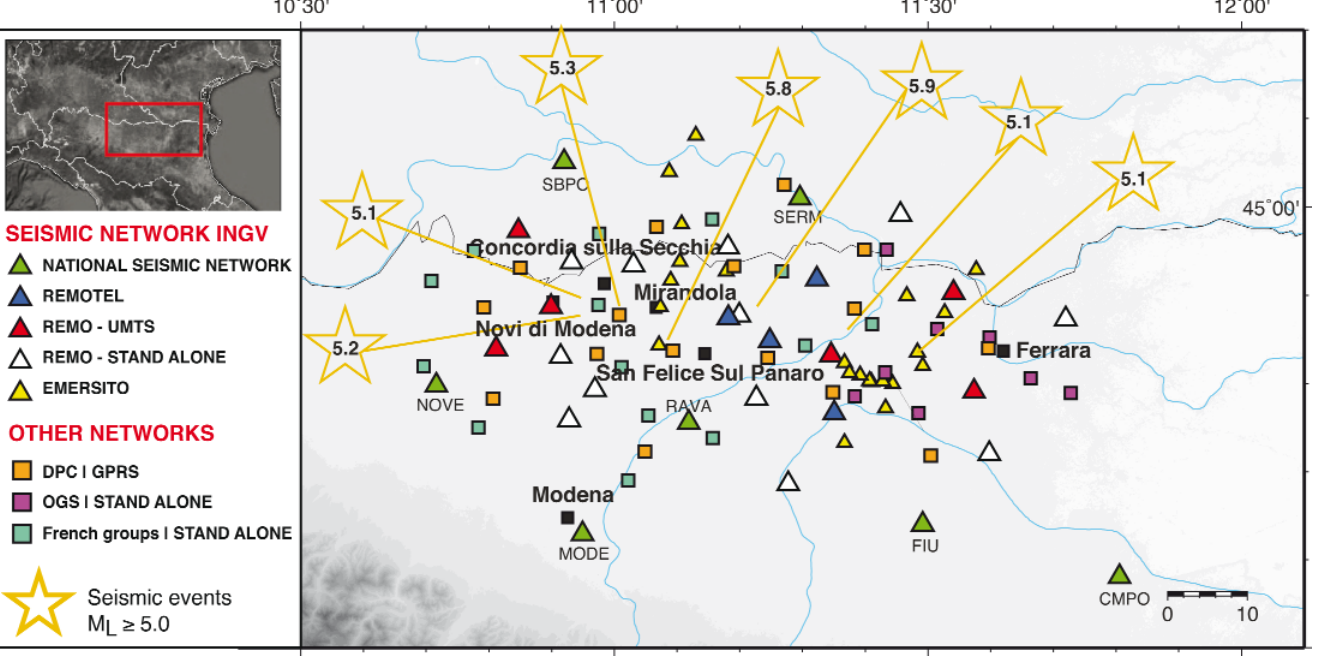
Figure 3. Map of the seismic stations deployed after May 20, 2012. Triangles, INGV permanent (green) and temporary stations; squares, stations from other Institutes; stars, earthquakes with magnitude